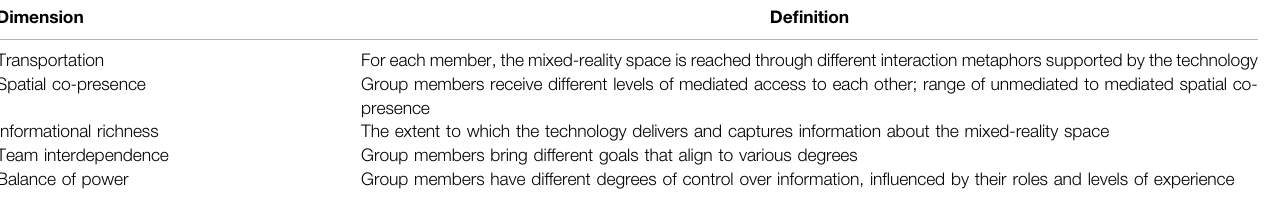
TABLE 1 | De fi nitions of the fi ve CAVR dimensions of asymmetry (Ouverson and Gilbert, 2021). Give space as per author request Tables 1, 3, 4, and 5 are a little compact, which negatively impacts readability. Could the rows be spaced a bit further from one another? Dimension De fi nition